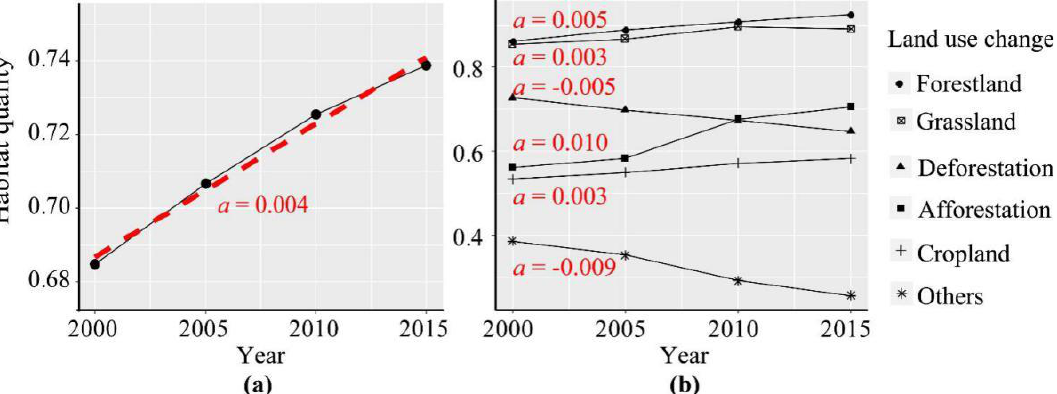
Figure 2. Linear trend analysis of the habitat quality of the TGR area ( a ) and temporal variations of the habitat quality for different land use change types ( b ). Note: In order to quantify the dynamic of habitat quality score, we used a least-square linear regression model to fit the habitat quality score. The changing trend is described by the modelled slope which is a in the figure. The black broken line is the estimated results, and the red dotted line is the trend line of habitat quality score.